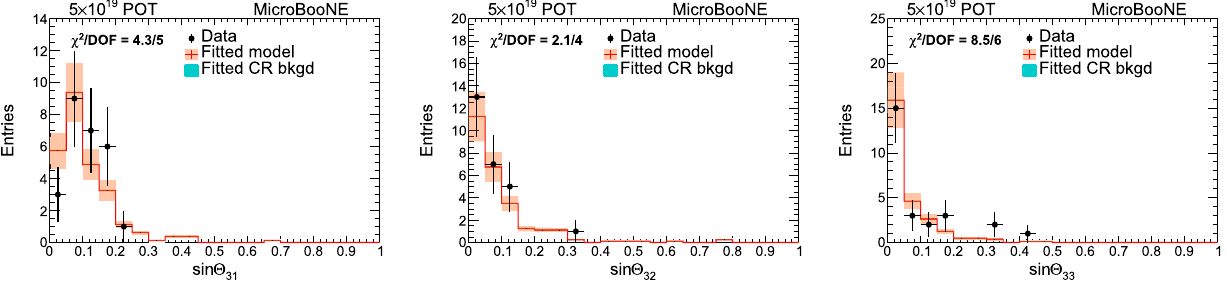
Fig. 24 Multiplicity = 3 sin (cid:17) distribution for candidate muon (left); for second longest track (middle); for shortest track of the event (right) from neutrino-enriched sample for data and GENIE default MC